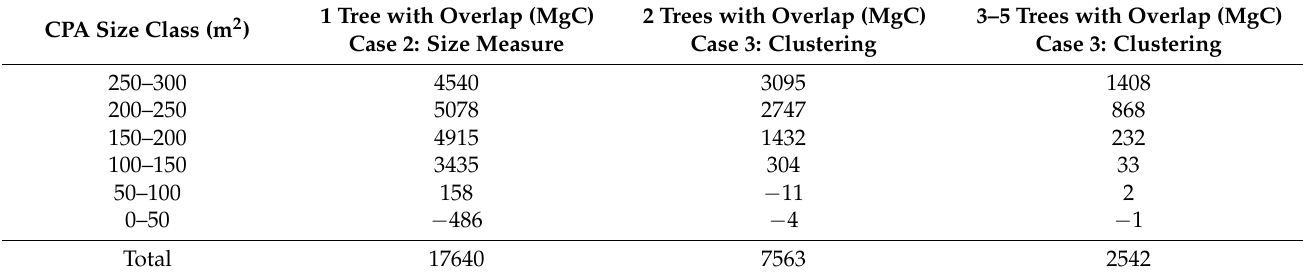
Table 5. Sources of carbon estimation differences between this study and the Brandt et al.